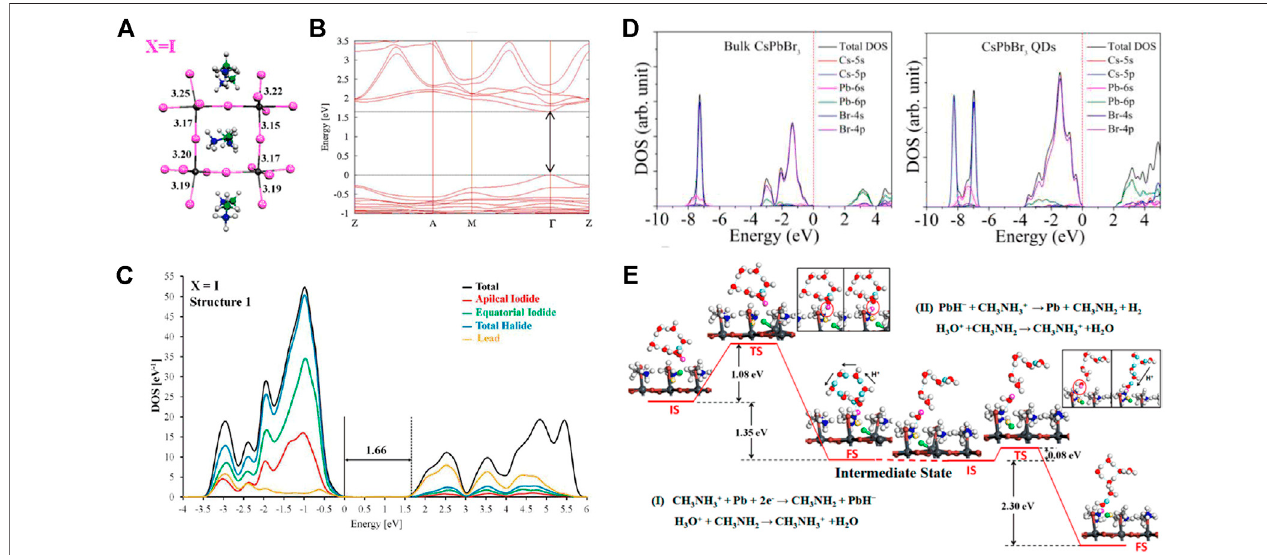
FIGURE 2 | (A) Optimized geometrical structures, (B) calculated band structure, and (C) DOS of MAPbI 3 (Grimme et al., 2010). Copyright (2013) American Chemical Society. (D) Calculated densities of states diagrams of bulk CsPbBr 3 and CsPbBr 3 QDs (Aryasetiawan and Gunnarsson, 1995). Copyright (2017) John Wiley and Sons. (E) PbAAA reaction pathway for H 2 generation on MAPbI 3 surface in acidic solvent (Jiang and Zhang, 2020). Copyright (2018) American Chemical